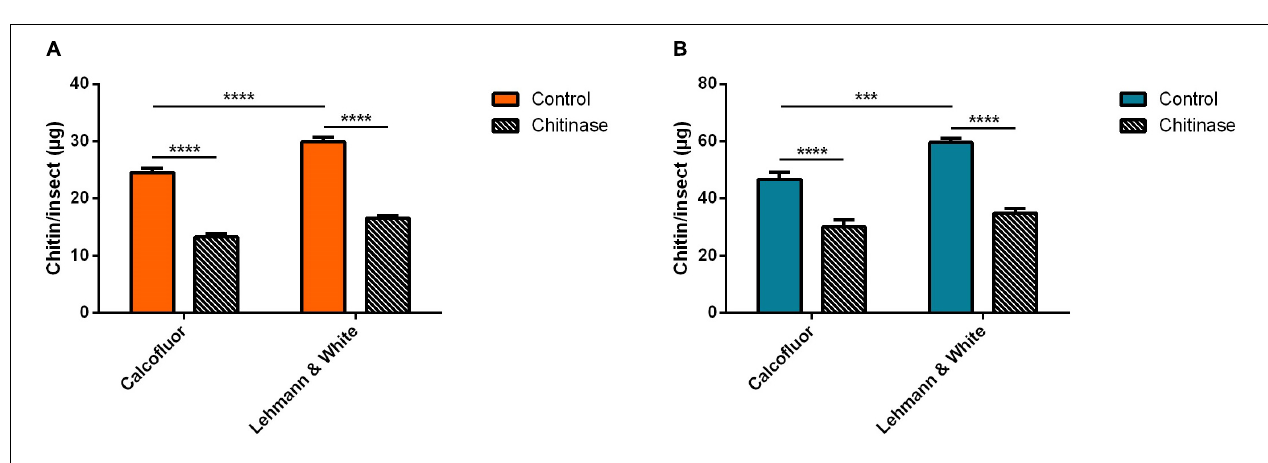
FIGURE 3 | Chitin content assessment in adult Lutzomyia longipalpis pooled in groups of 20–40 in 200 µ L distilled water, treated or not with 1 mg/mL chitinase from Streptomyces griseus , comparing measurements with the methods by Lehmann and White (1975) and calcofluor fluorescent brightener. (A) Male L. longipalpis . (B) Female L. longipalpis . Bars are means of 20 biological replicates with the standard error of the mean (SEM). Asterisks denote statistically significant differences, * p ≤ 0.05, and **** p ≤ 0.0001.